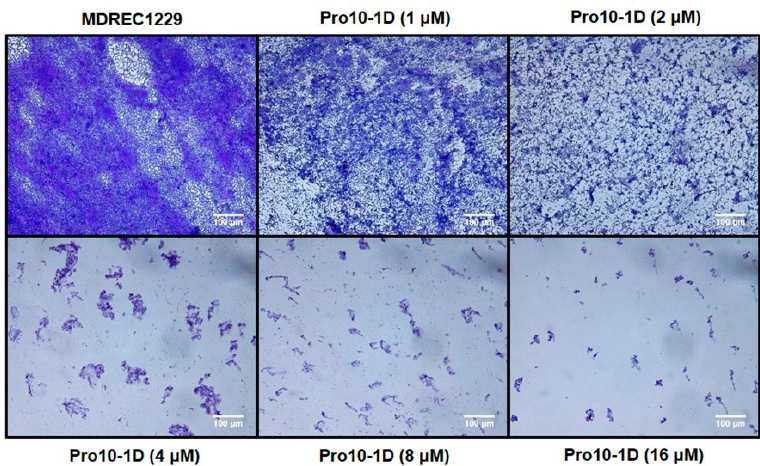
Figure 8. Light microscopic images representing the antibiofilm effect of Pro10-1D against MDREC 1229: MDREC 1229 cells were allowed to adhere the polystyrene surface of the culture plate and were then exposed to Pro10-1D (0–16 µM) for 16 h. Strains were cultured in Mueller–Hinton (MH) media, and biofilm formation was evaluated by crystal violet staining. Pro10-1D-exposed biofilms appeared thinner and scantier than untreated MDREC 1229; these effects were dose-dependent. Scale bar, 100 µm. 2.11. Suppression of Inflammatory Cytokine Expression Levels in LPS-Stimulated RAW264.7